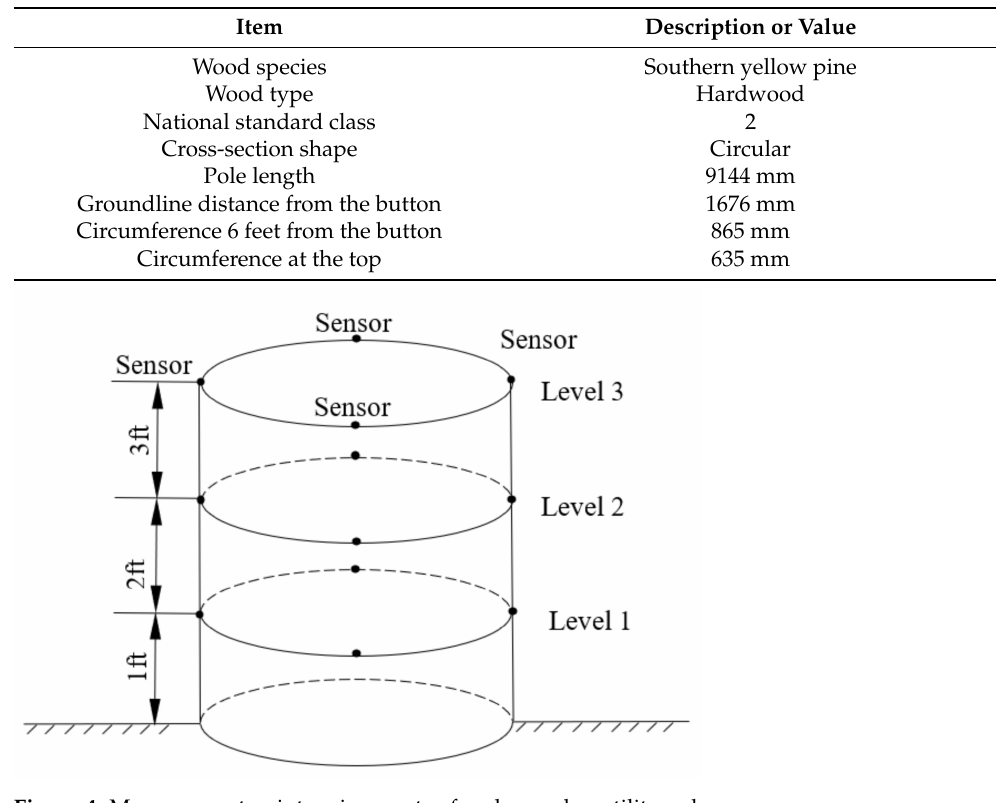
Table 4. Detailed descriptions and parameters of the tested wooden utility poles.